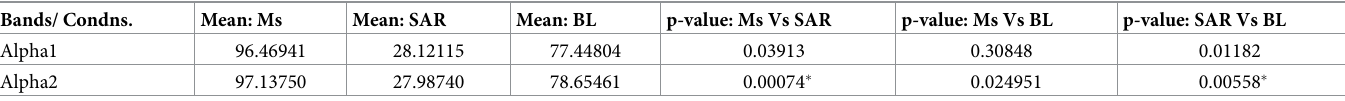
Table 2. Mean CSD analysis. Bands/ Condns. Mean: